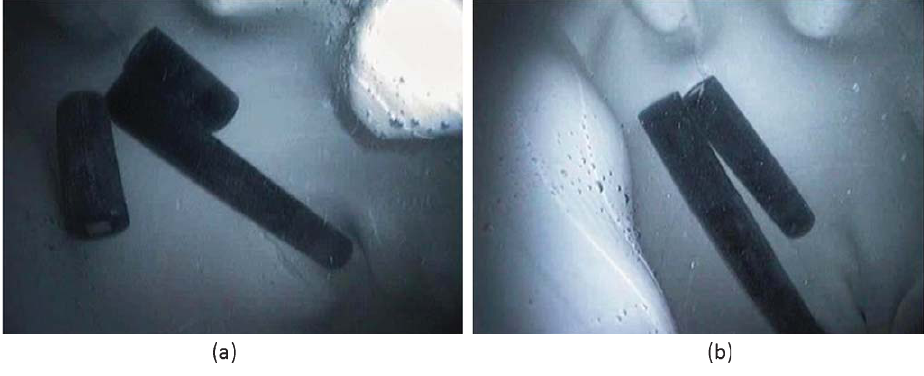
Fig. 11. Experiment No.3 showing assembled mock-ups in the stomach simulator: (a) before contraction (No-assembly: 2, three-assembled: 1) and (b) final configuration (Two-assembled: 1, Three-assembled: